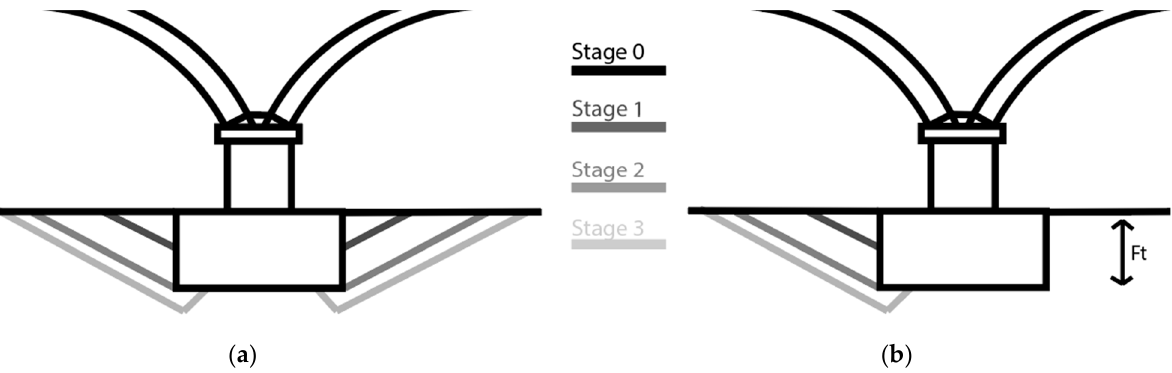
Figure 4. Stages of the scour depth when compared to the footing thickness ( 𝐹 (cid:3047) ) for the different scour scenarios: ( a ) symmetric; ( b ) asymmetric. scour scenarios: ( a ) symmetric; ( b )